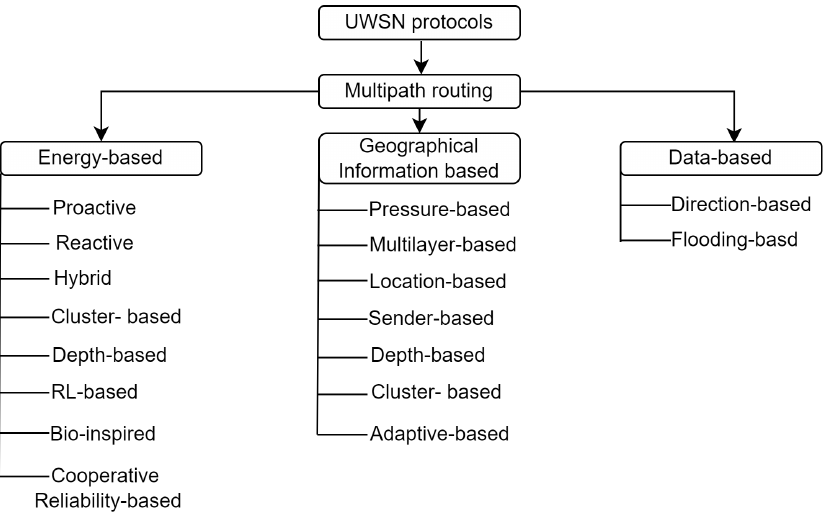
Figure 2. Taxonomy of Underwater Wireless Sensor